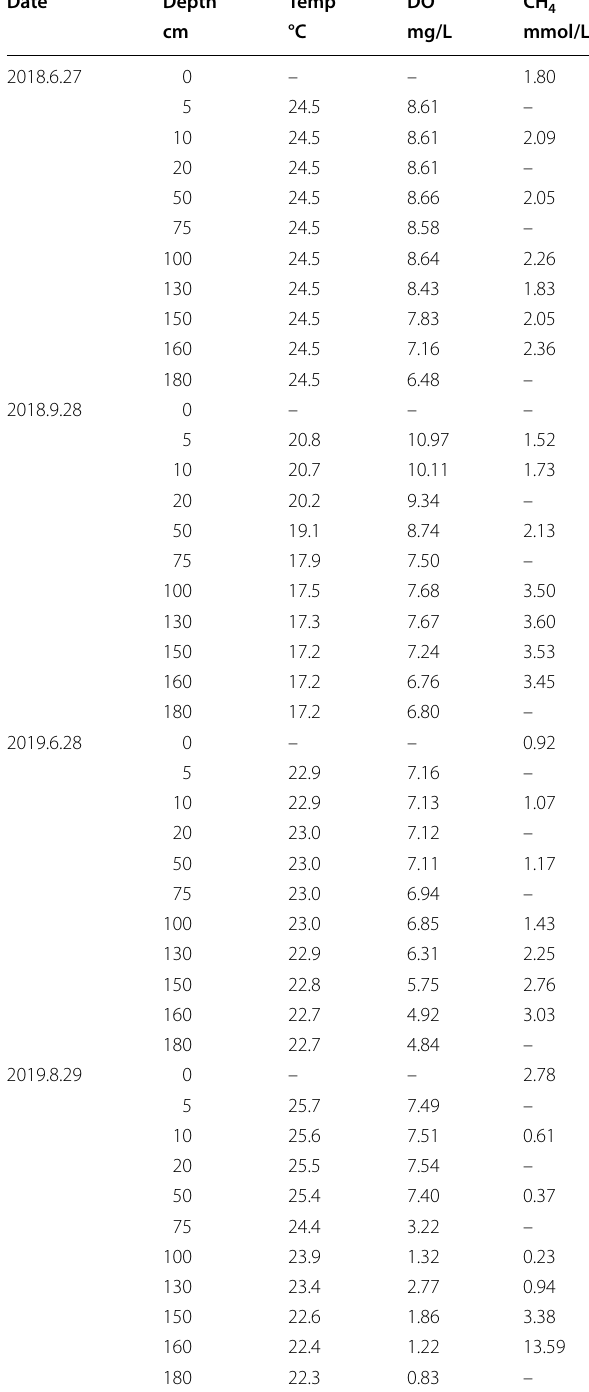
Table 6 Water column profiles at the sampling site